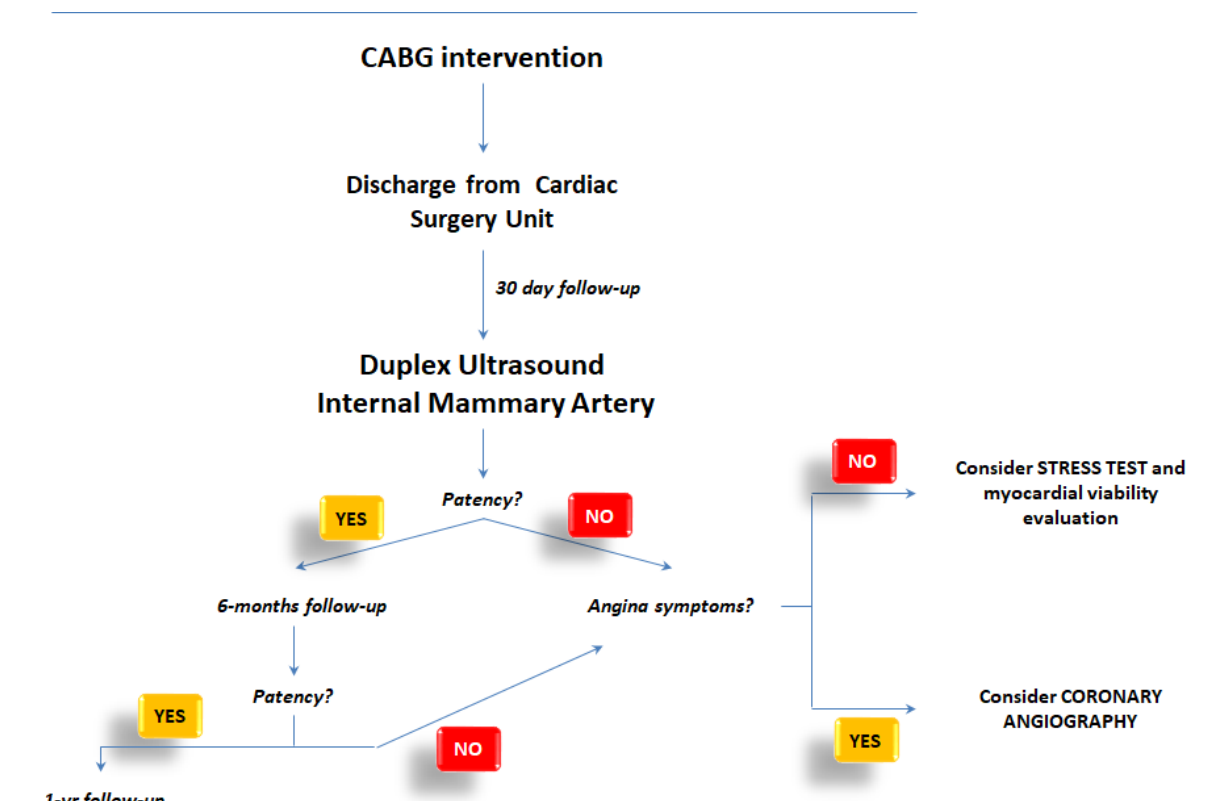
Figure 3. Flow chart for the application of the ultrasound evaluation of the LIMA in daily clinical practice.